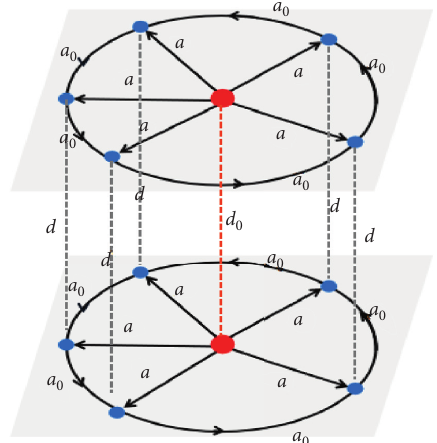
Figure 9: Schematic diagram of the structural model of Network